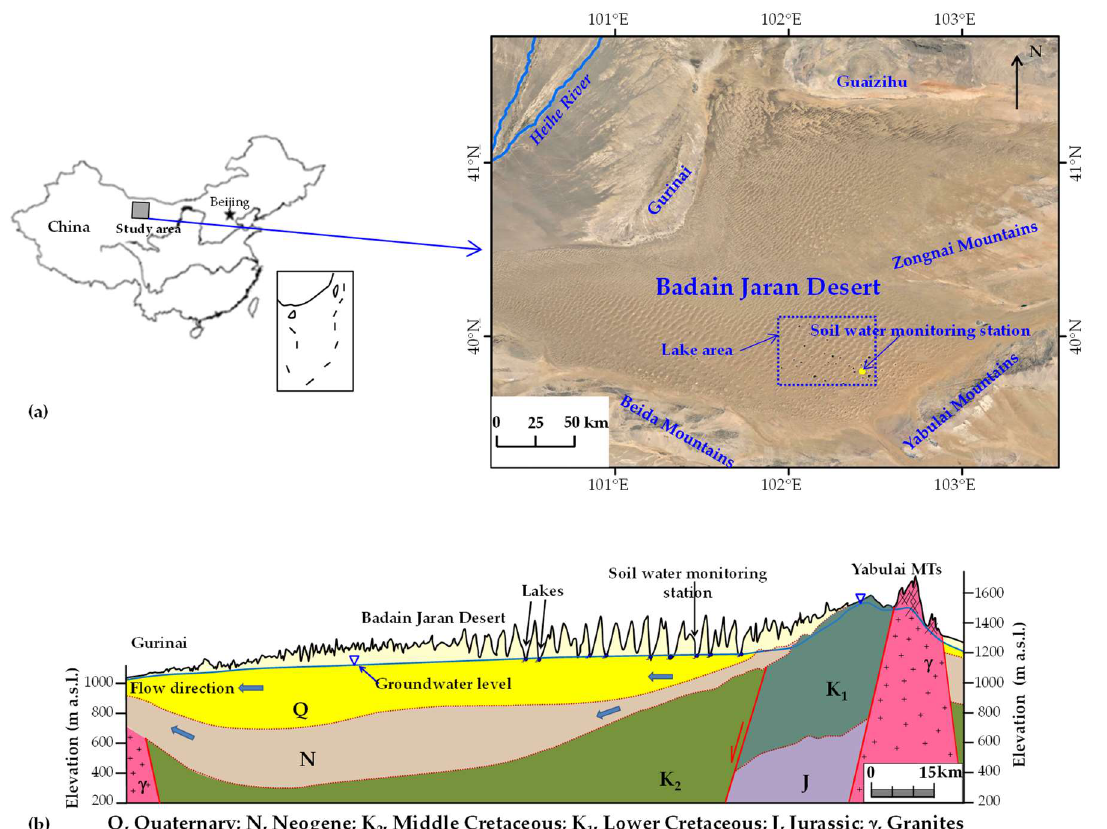
Figure 1. ( a ) Location of the Badain Jaran Desert; ( b ) a schematic geological profile between the Gurinai and Yabulai Mountains, modified from Wang and Zhou (2018) [8].